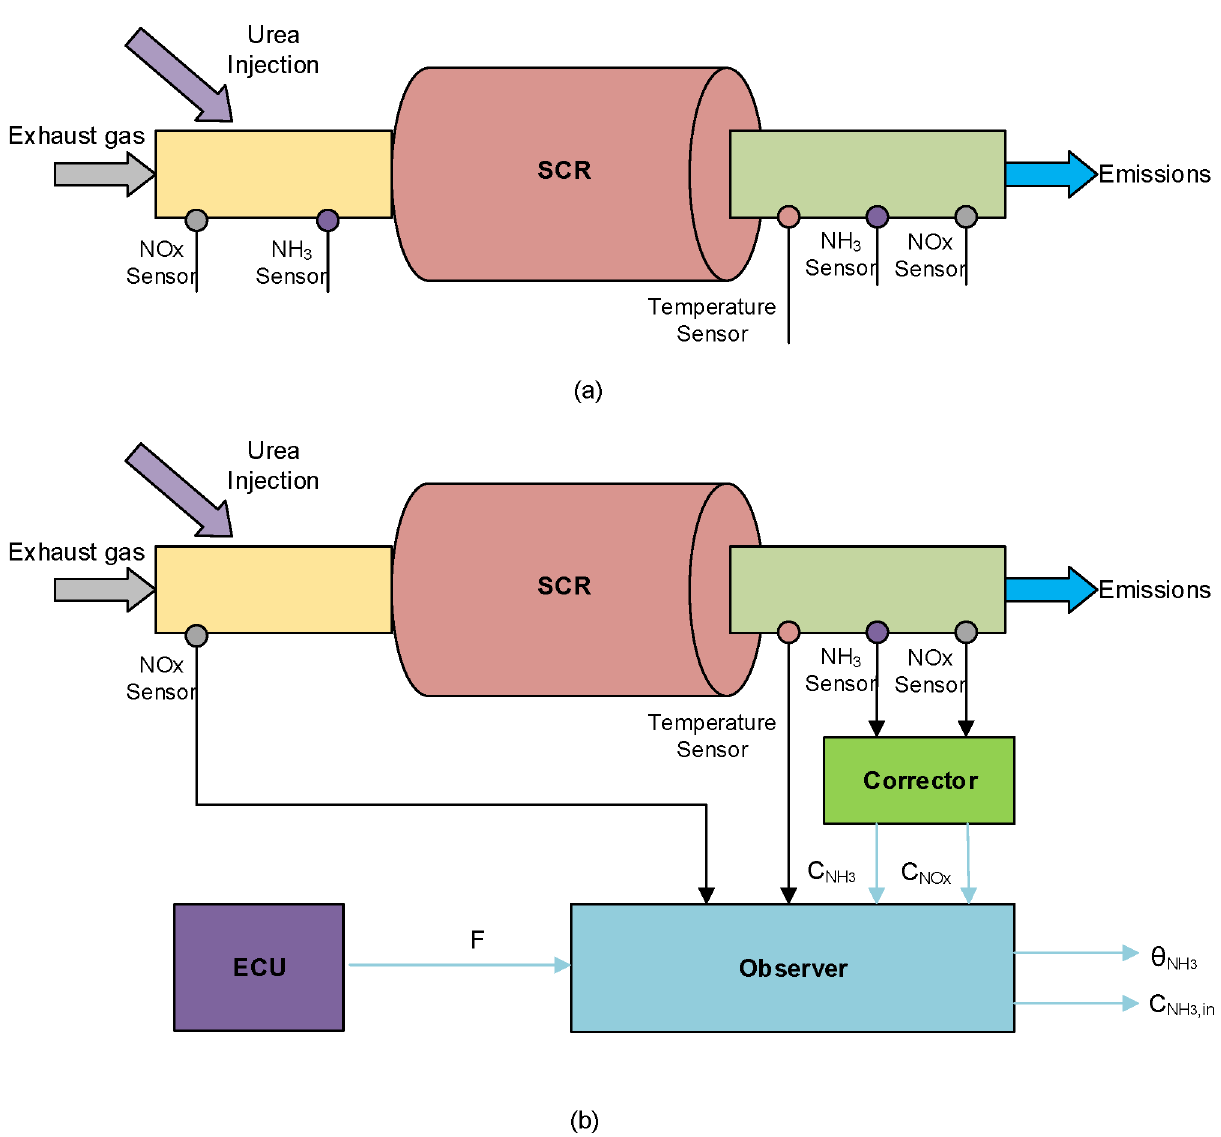
Fig 2. Schematic diagram of SCR system with corresponding sensors (a) and with observer architecture diagram (b).